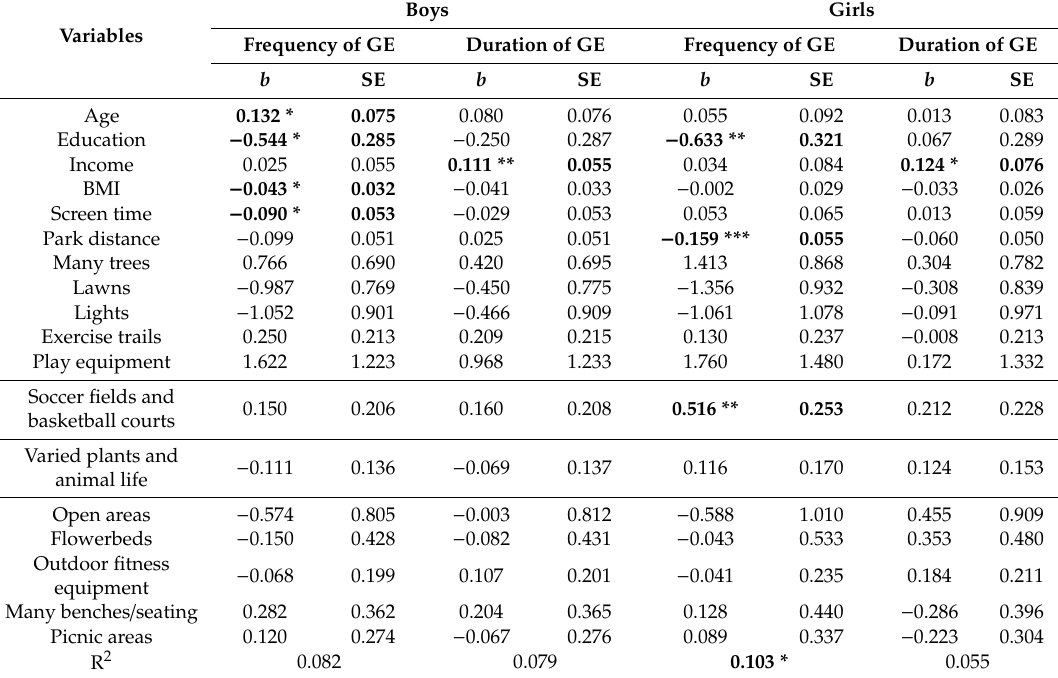
Table 4. Associations between characteristics of UGSs and adolescents’ GE, stratified by gender.